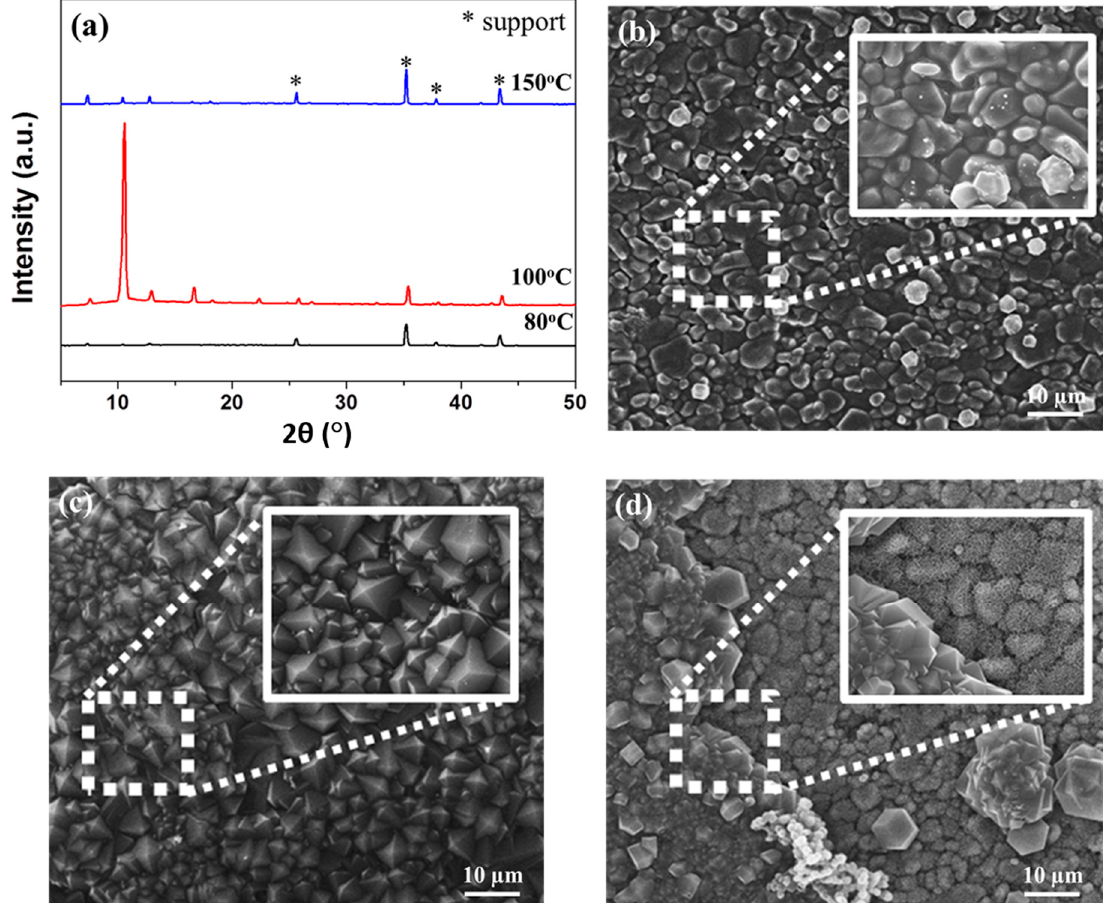
Figure 8. ( a ) XRD patterns and SEM images of Co44-ZIF-8 membrane prepared with different reaction temperatures: ( b ) 80, ( c ) 100, and ( d ) 150 °C.